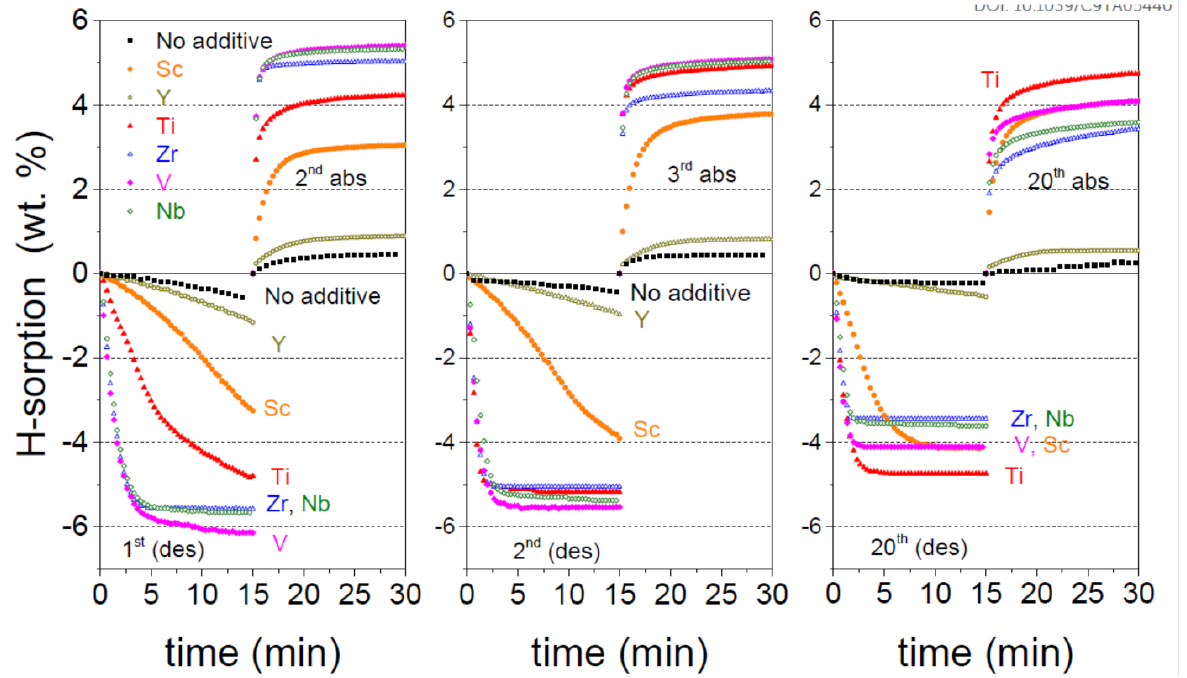
Figure 40. Hydrogen sorption curves at 573 K of MgH 2 –ETMH x nanocomposite for different sorption sweeps. Absorption and desorption hydrogen pressures are fixed to 0.8 and 0.03 MPa, respectively. Sorption time is limited to 15 min. Reproduced with permission [37]. Copyright 2019, Royal Society of